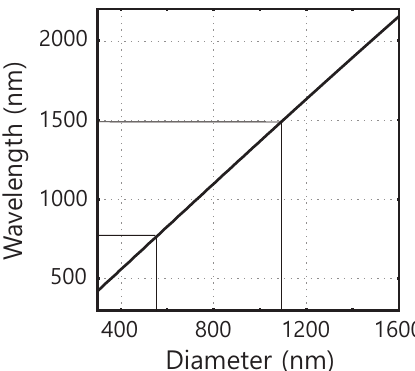
Figure 4. Wavelength for single mode condition of a silica-air waveguide as a function of a diameter, d = 2 a